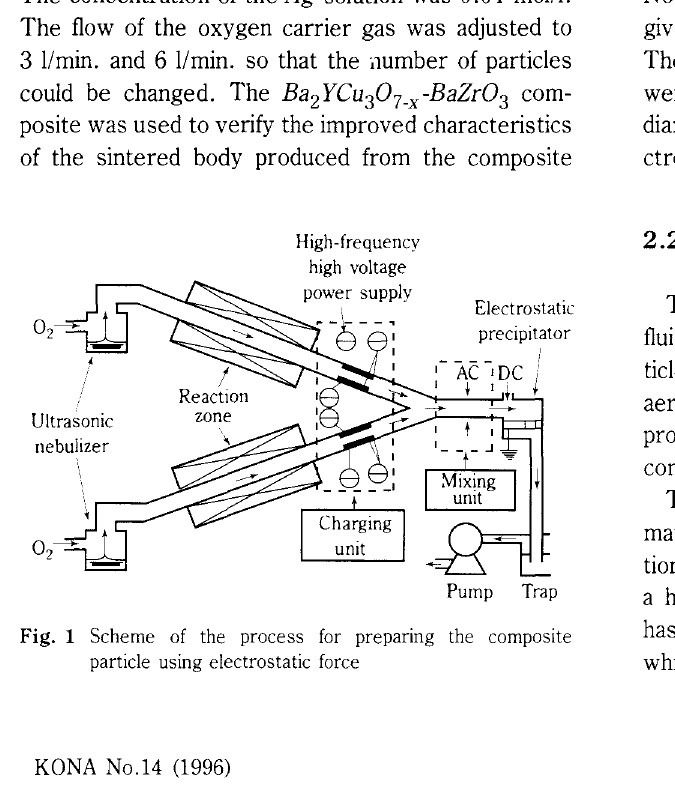
Fig. 1 Scheme of the process for preparing the composite particle using electrostatic